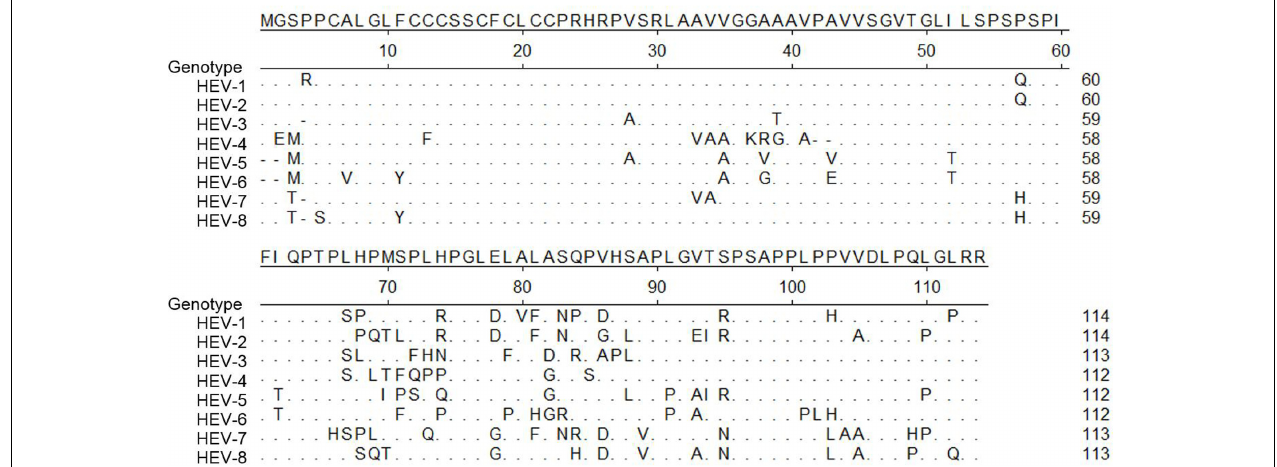
FIGURE 2 | Alignment of amino acid sequence of ORF3 of eight genotypes in Orthohepevirus A virus. Alignment of amino acid sequence of pORF3 from all seven genotypes classified as Orthohepevirus A virus. Genotype 1 (GenBank accession # M73218), Genotype 2 (GenBank accession # M74506), Genotype 3 (GenBank accession # AF082843), Genotype 4 (GenBank accession # AJ272108), Genotype 5 (GenBank accession # AB573435), Genotype 6 (GenBank accession # AB602441), Genotype7 (GenBank accession # KJ496143) and Genotype8 (GenBank accession # KX387867). Those residues that are the same as consensus sequence are shown as